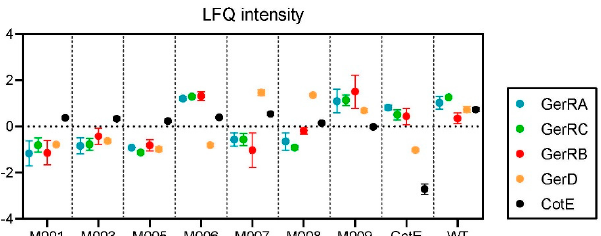
Figure 4. The abundances of three proteins encoded by the gerR operon (GerRA, GerRC and GerRB), GerD and CotE in spores of various strains. The z-scores of the LFQ intensities are shown to compare relative expression levels between different strains of a given protein; note that the quantitative data for GerRB are based on only a single peptide.